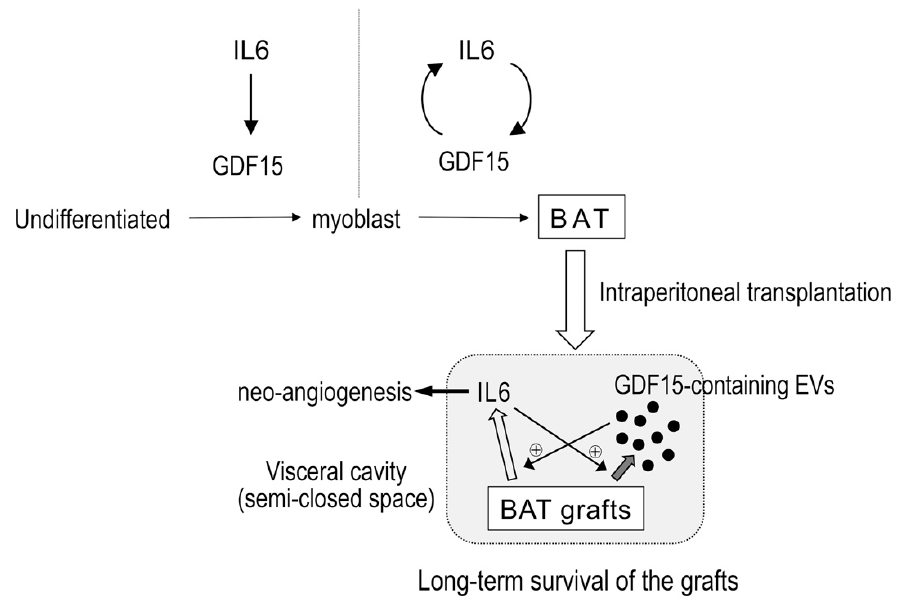
Figure 9. Model. IL6 induces GDF15 in the former phase of the differentiation of hESCs into BAs, whereas GDF15 and IL6 create a mutually inducing loop in the later phase. The GDF15, which may be secreted as a component of large-sized EVs, and IL6 potentiate and stabilize neovascularization, guaranteeing long-term survival of BAT grafts.